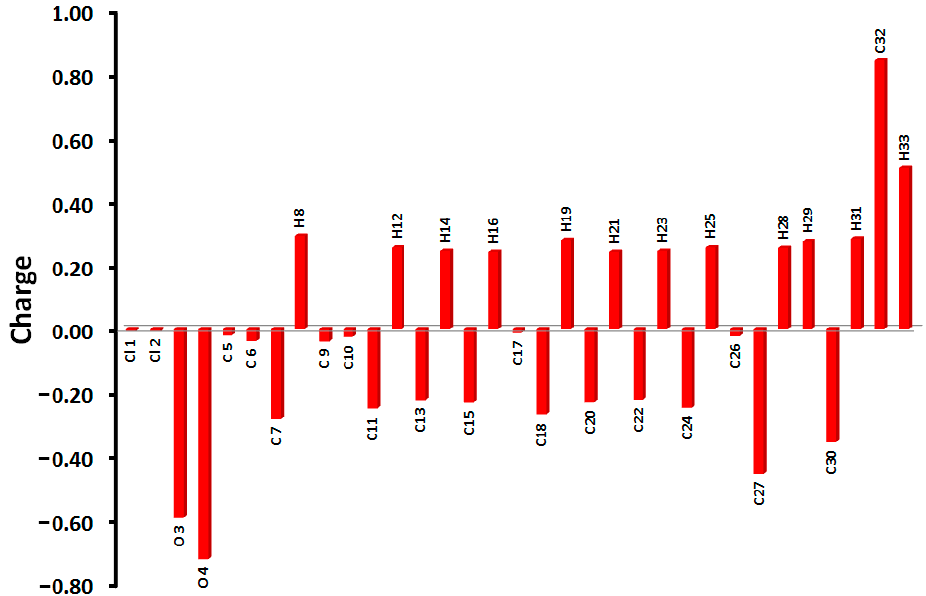
Figure 8. Natural atomic charge populations for 5 .